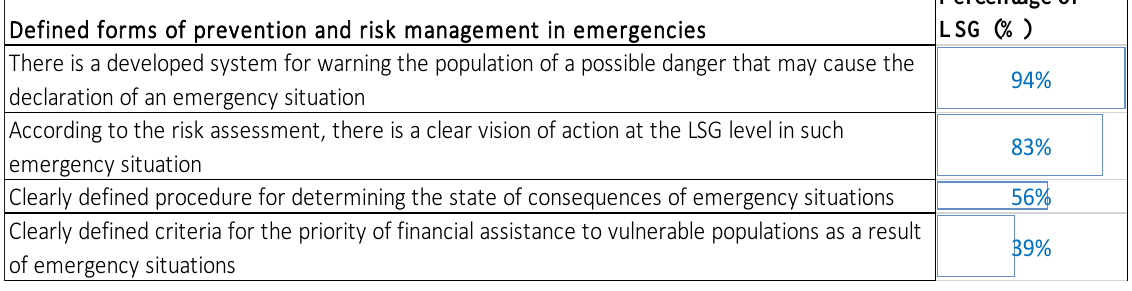
Table 4: Defined Forms of Prevention and Risk Management in Emergencies (Source: Authors’ research)